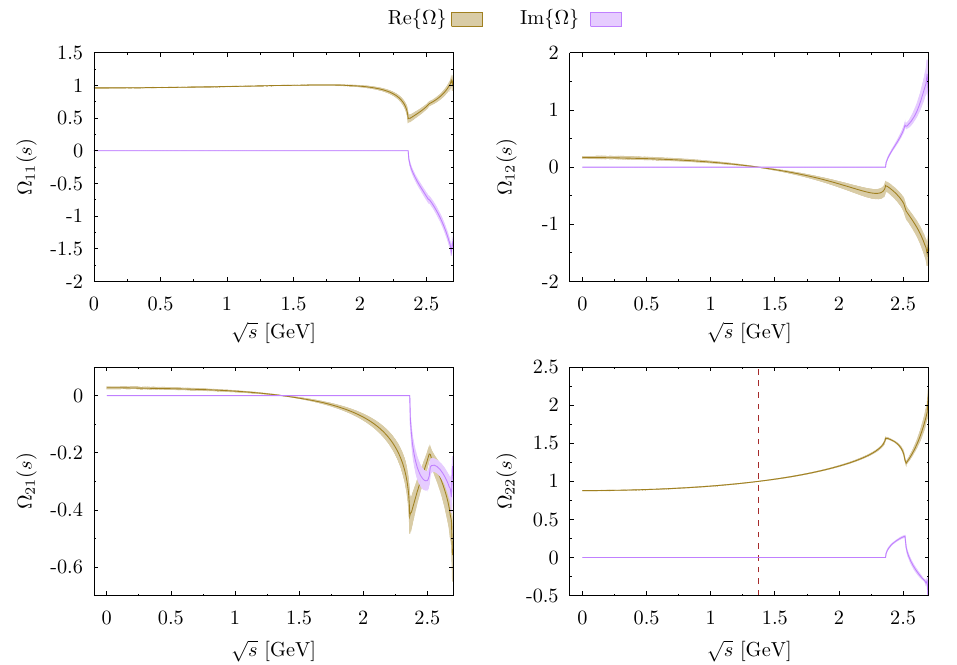
Fig. 1 Phase shifts, inelasticities [see Eq. (27)] and amplitude moduli from T ( 1 , 0 ) been obtained by Monte Carlo propagating the uncertainties of the LECs quoted in Ref. [56]